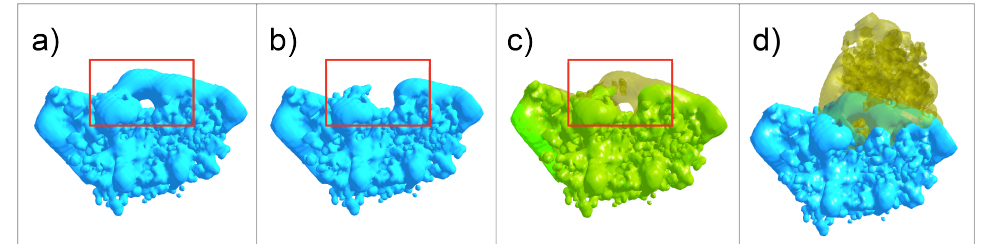
Figure 3. Effect of Nullification on Barnase-Barstar. ( a ) Wildtype Barnase electrostatic surface at isopotential of +1 kT/e. ( b ) Barnase nullified at residue 59, electrostatic surface at isopotential of +1 kT/e. ( c ) Overlap of wildtype (transparent yellow) and nullified Barnase (green) surfaces. ( a – c ) The red square encompasses the main difference in isopotential surface due to nullification. ( d ) Wildtype Barnase (blue) in complex with Barstar (transparent